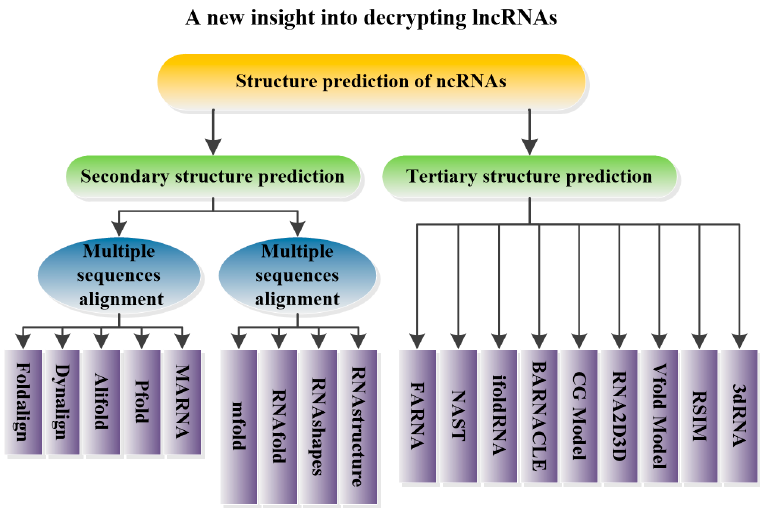
Figure 1. The graphical abstract of this review.